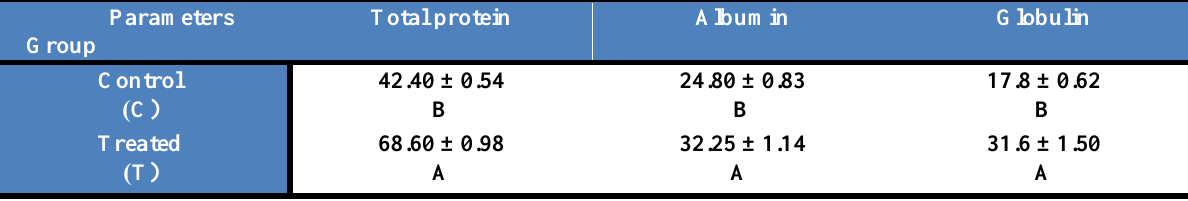
Table, 2: Effect of ethanolic extract from Metracaria chamomella (Mc) on serum total protein, albumin and globulin concentrations (gm/dL) in male rabbits.